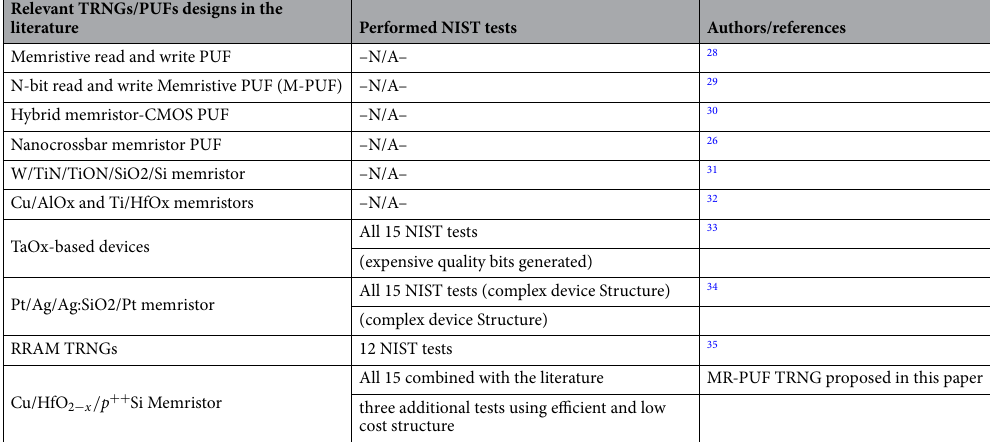
Table 3. Comparison between the proposed Memristor design and the relevant Memristors presented in